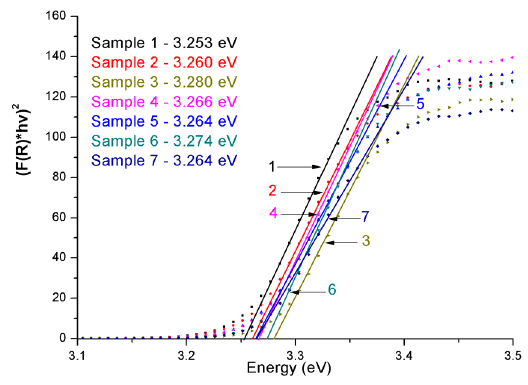
in ionic liquids